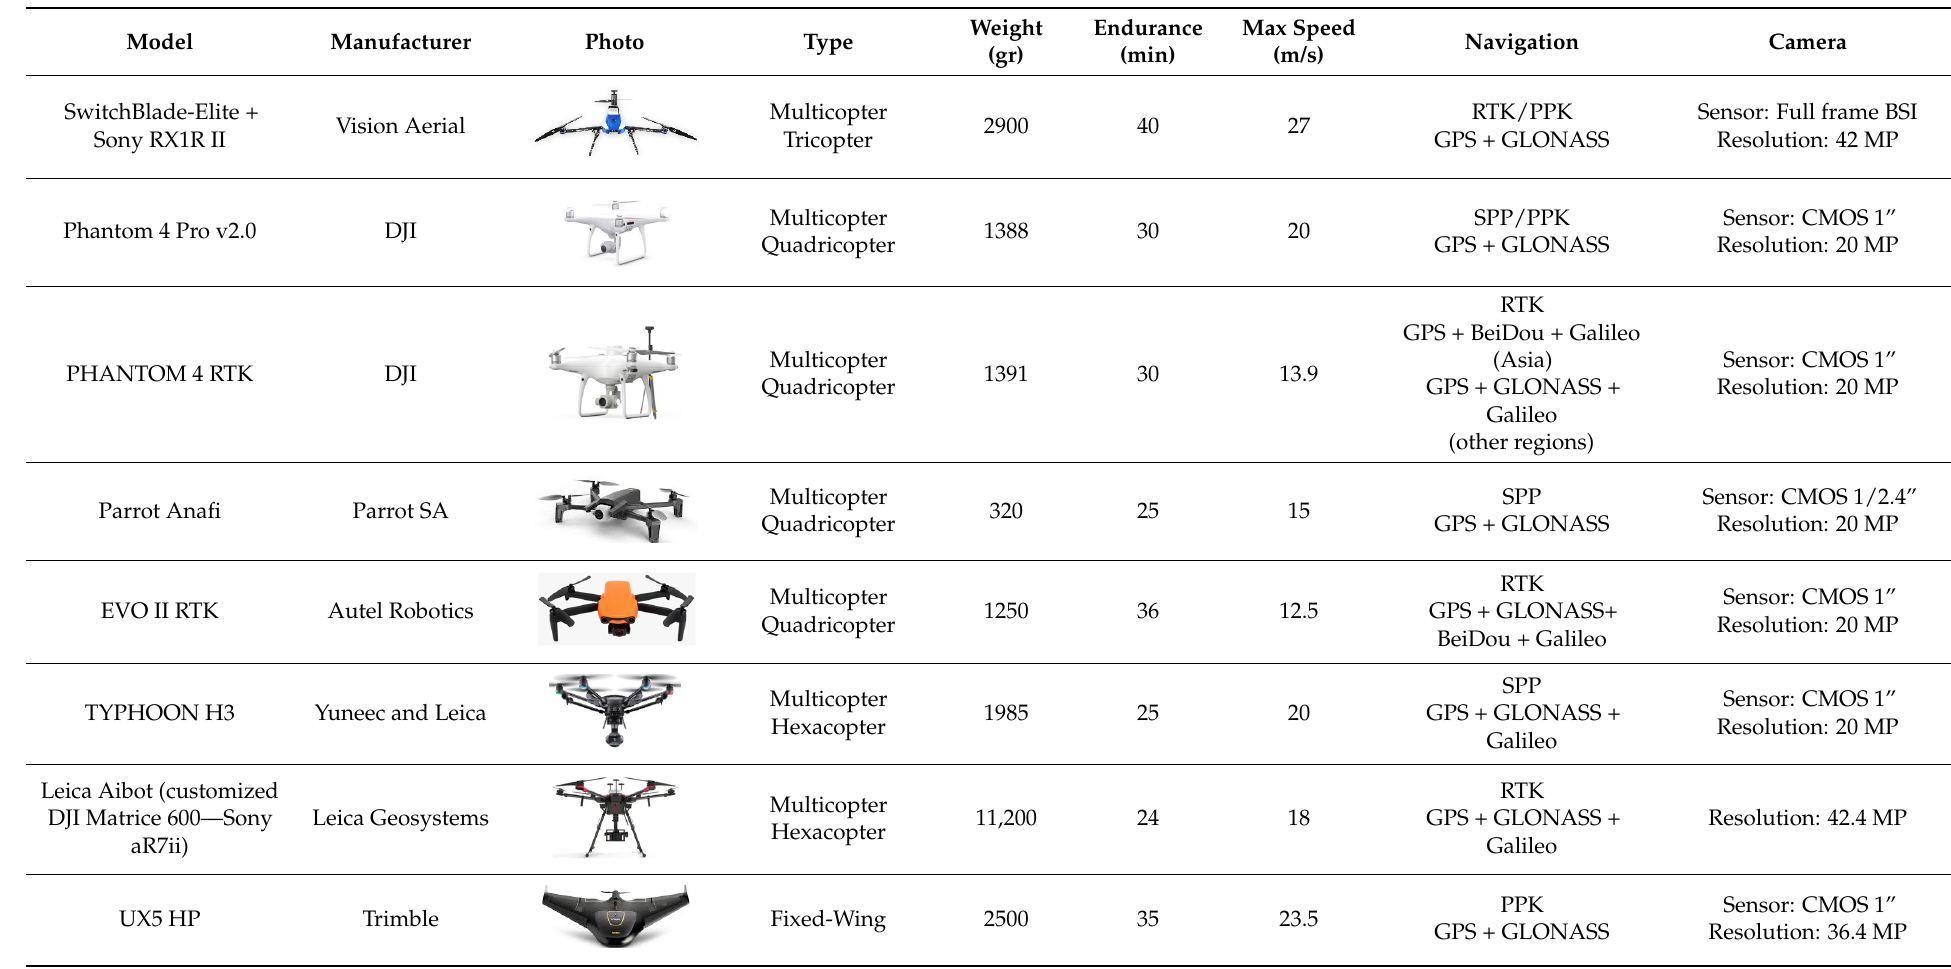
Table 4. Commercial UASs.